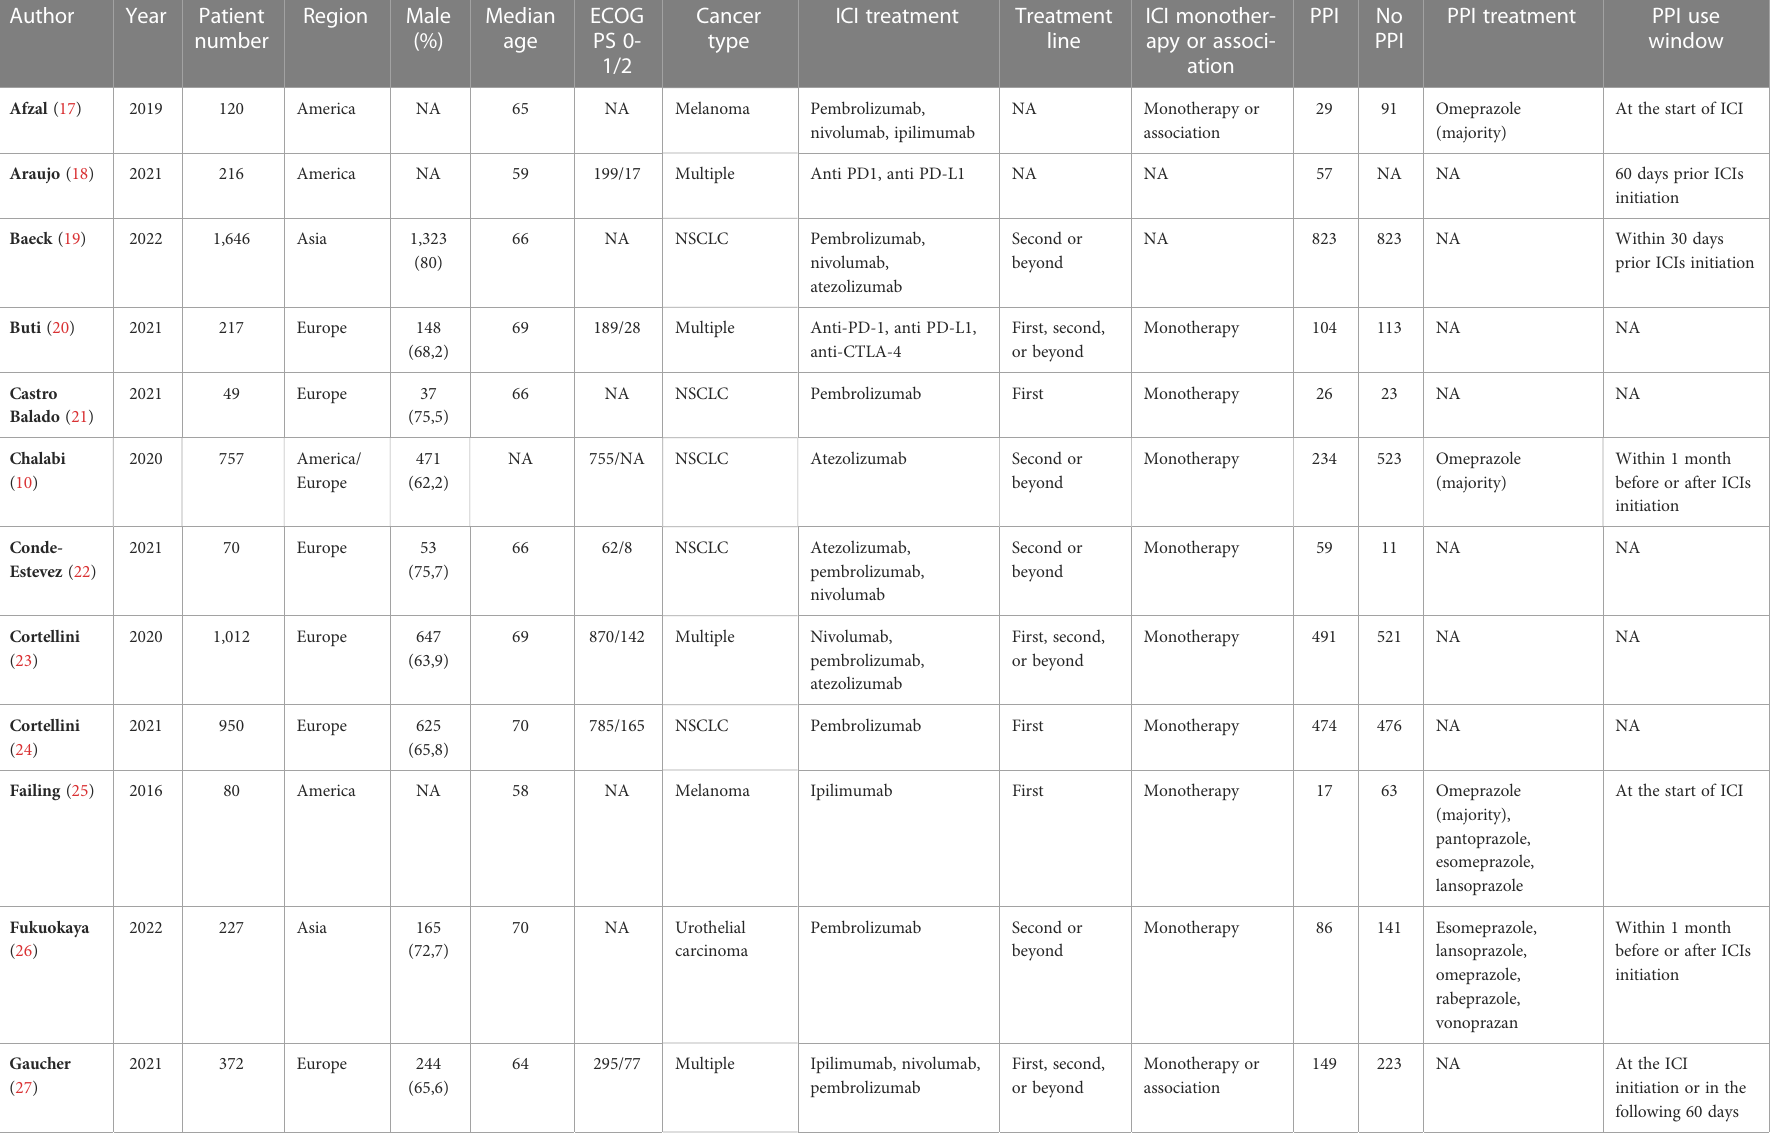
TABLE 1 Baseline characteristics of included